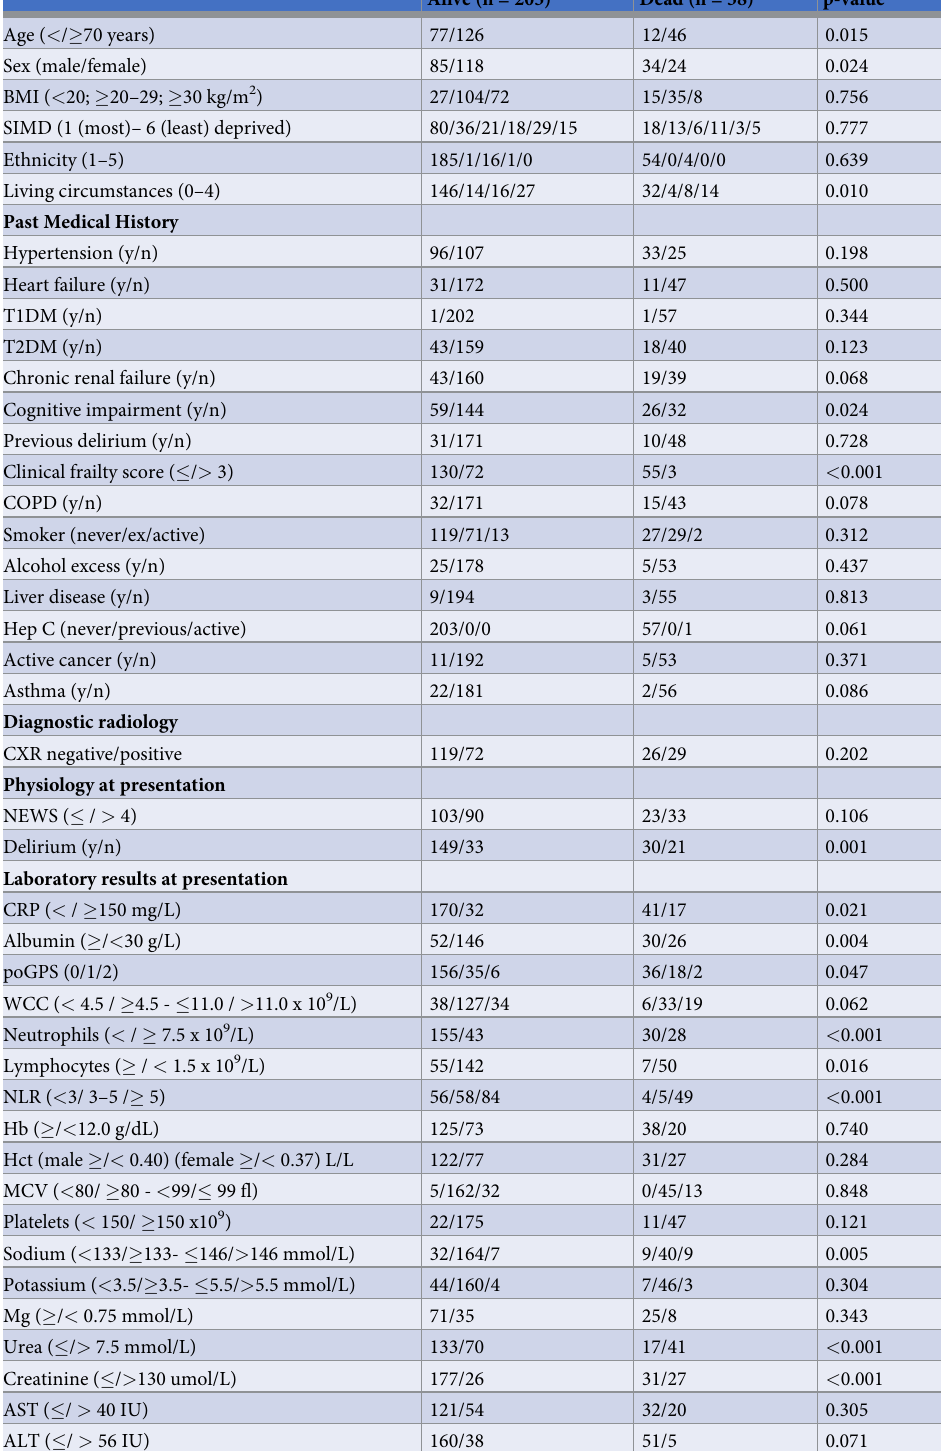
Table 5. Univariate analysis of demographical, clinicopathological characteristics and 30-day mortality in the sec- ond cohort of patients admitted with confirmed COVID-19 (n =